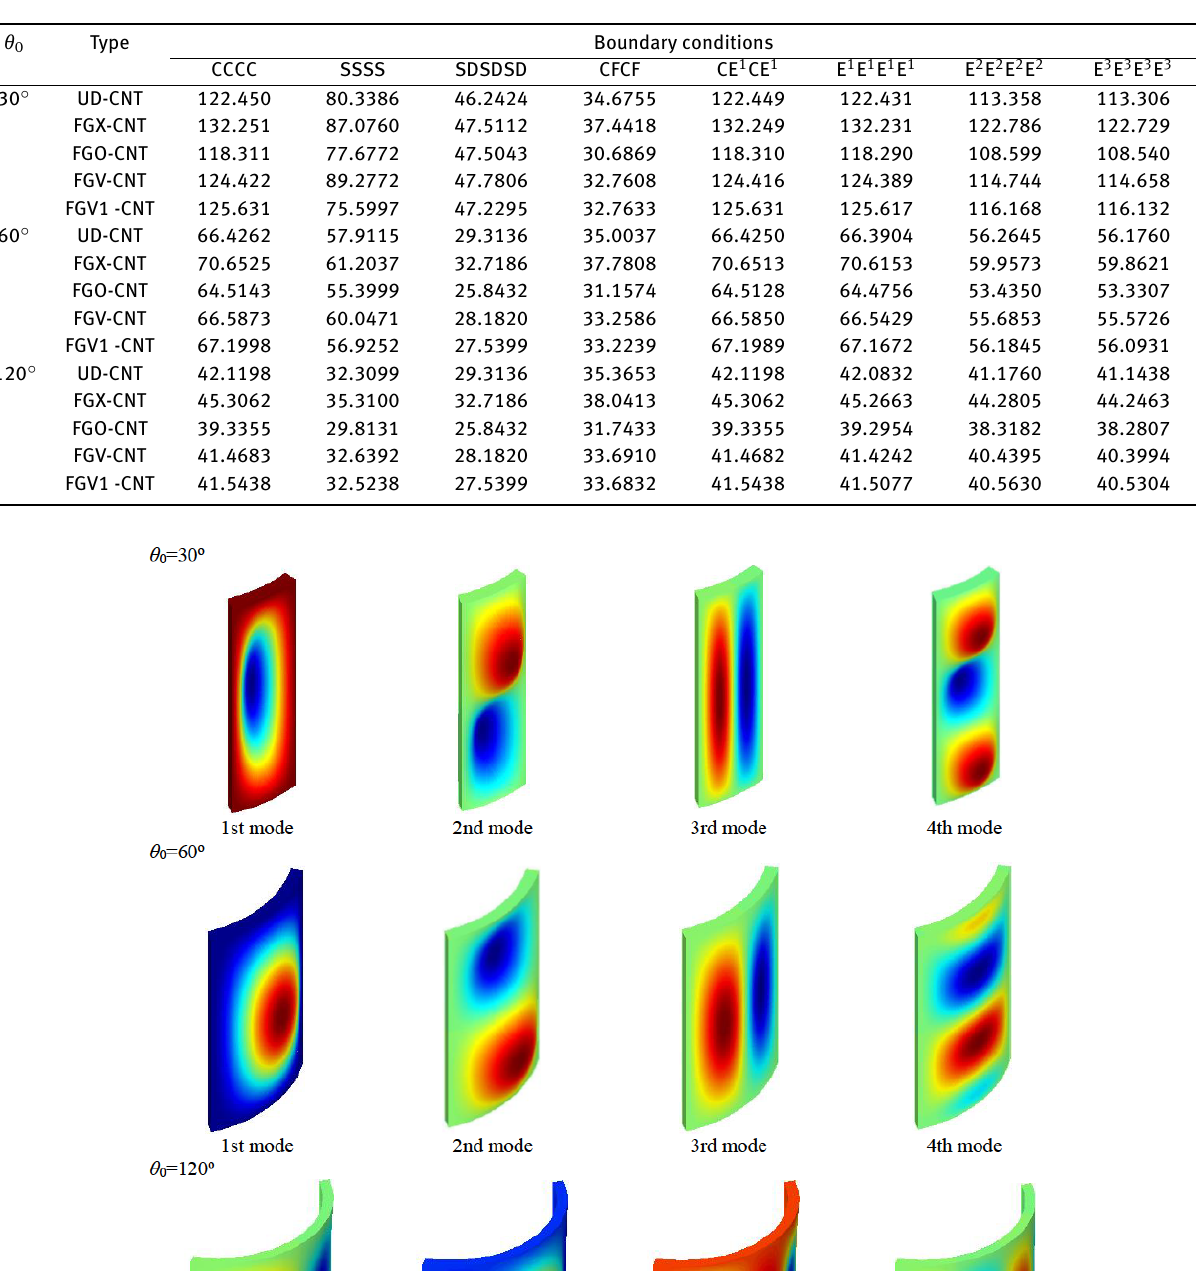
Table 8: Fundamental frequency parameters Ω for FG-CNTRC panels with various boundary conditions and CNT volume fractions V tcnt = 0.28 .